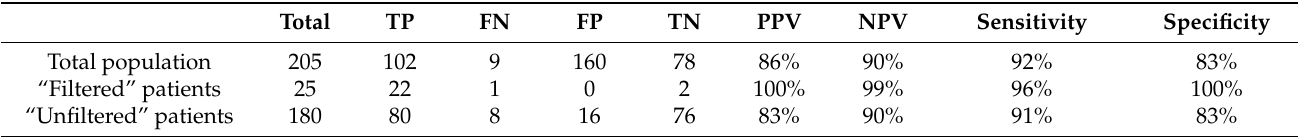
Table 6. Diagnostic value of the ITQ questionnaire compared to the expert’s final assessment ( n = 205 patients). RHELYPRO Study (2017–2019).